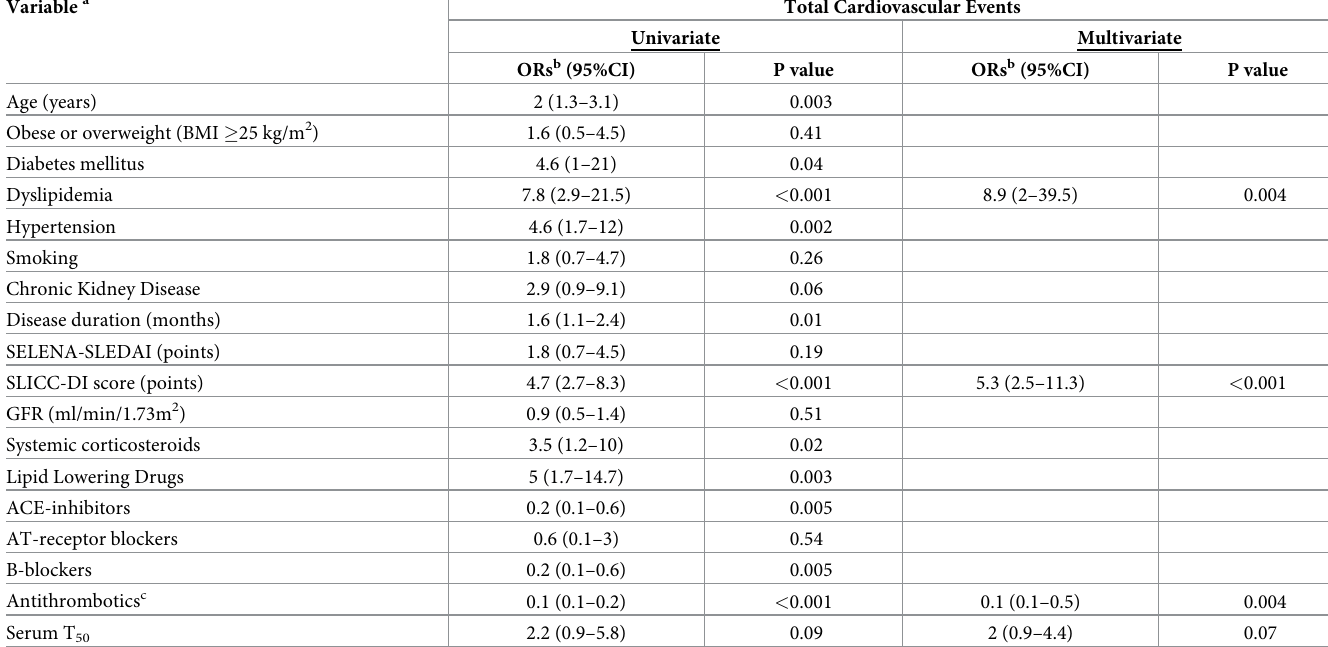
Table 3. Univariate and multivariate association of known predictors of atherosclerotic disease and serum calcification propensity score (T 50 ) at baseline with total cardiovascular